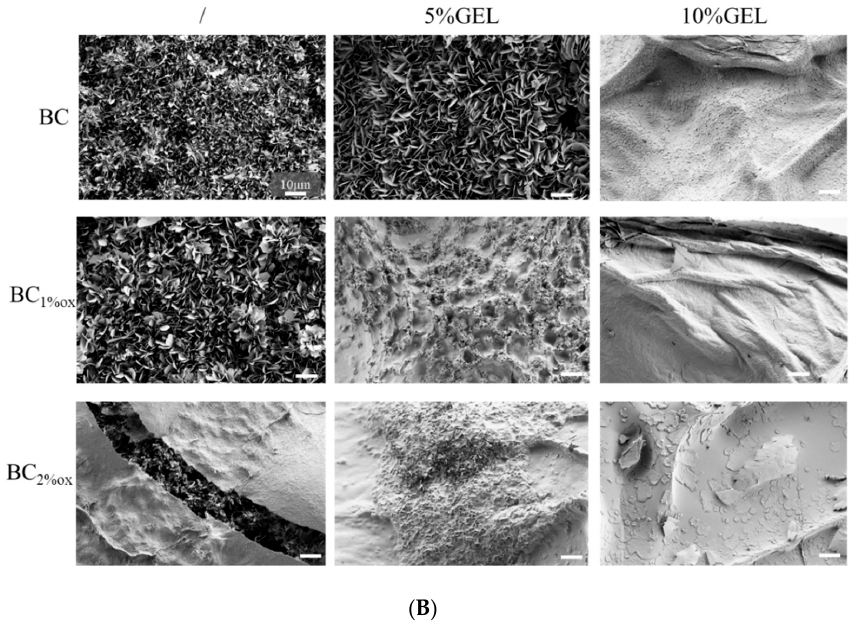
Figure 4. SEM micrographs of BC and BC–GEL membranes after 6 h of incubation in 10× simulated body fluid (SBF) media, containing non-oxidized ( A ); and oxidized (by 1% and 2% periodate) ( B ) BC. (EDX) data. The white scale bar presenting a 10- µ m length is applicable to micrographs under ( B